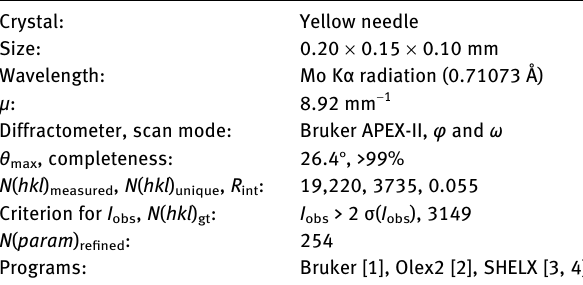
Table 1 contains crystallographic data and Table 2 contains the list of the atoms including atomic coordinates and displacement parameters.